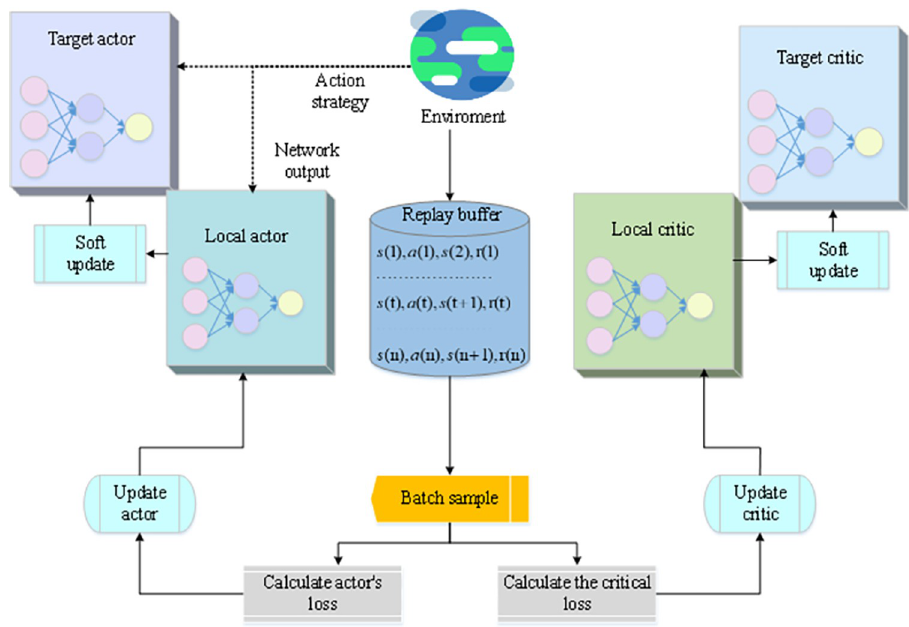
Fig 2. Implementation process of the DDPG algorithm.